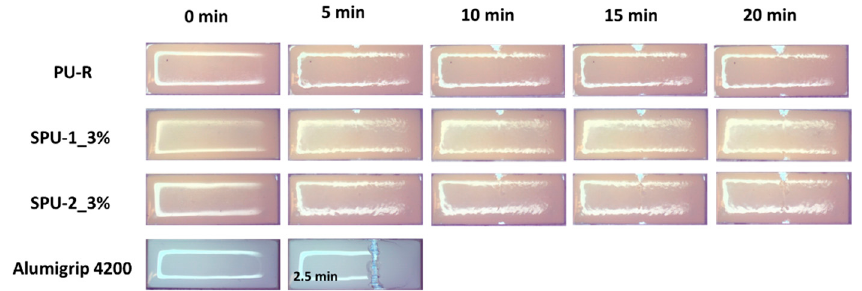
Figure 7. Water droplet erosion resistance of SPU coatings. Test conditions: 463 μ m water droplets, impact velocity of 175 m/s, impact angle of 90°, impact frequency of 42,000 droplets per minute.